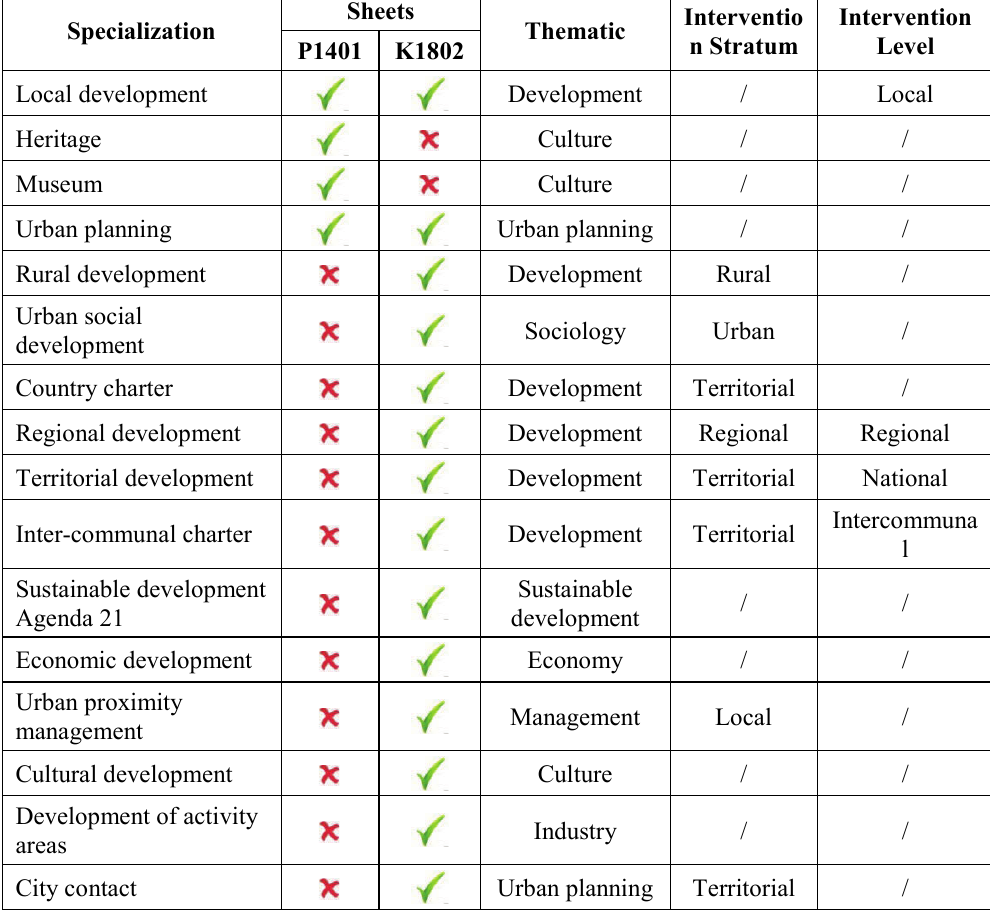
Table 6. Existing Specializations in Sheets P1401 and